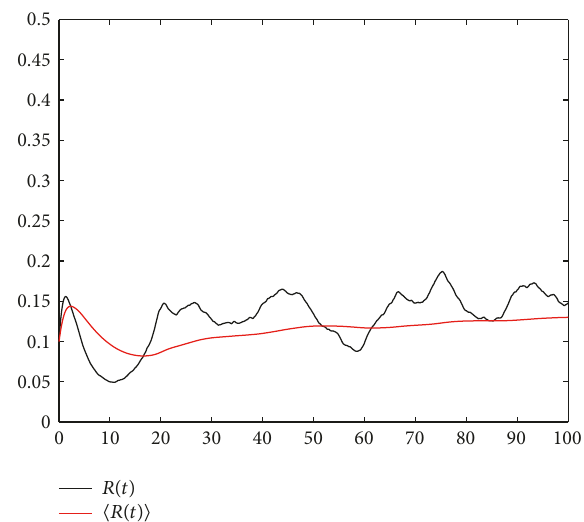
Figure 3: Computing simulation of the paths 𝑅(𝑡) for the SIRS epidemic model